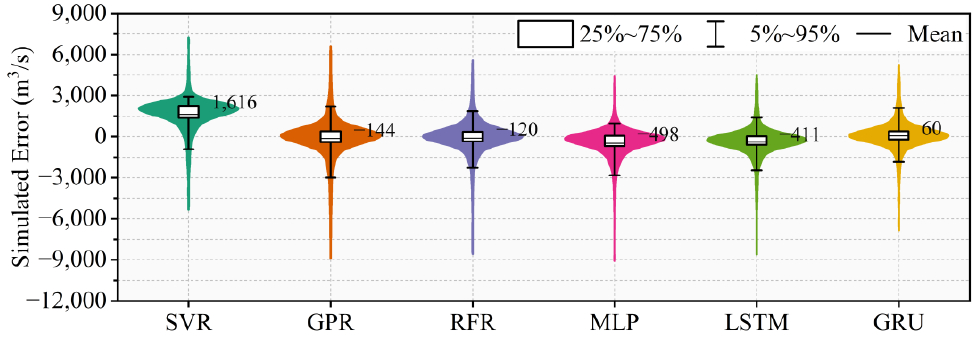
Figure 5. Violin plots of the simulated inflow errors of the TGR by different ML models during the testing period.